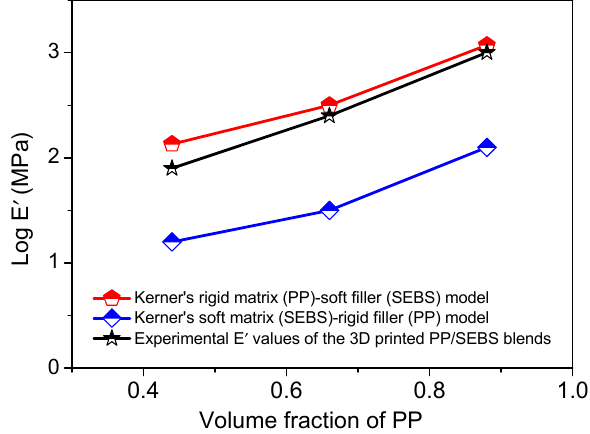
Figure 7. Storage modulus vs. volume fraction of PP. Kerner’s model was applied to predict the droplet-matrix morphology. Experimental storage modulus was compared with the storage modulus obtained using Kerner’s model.